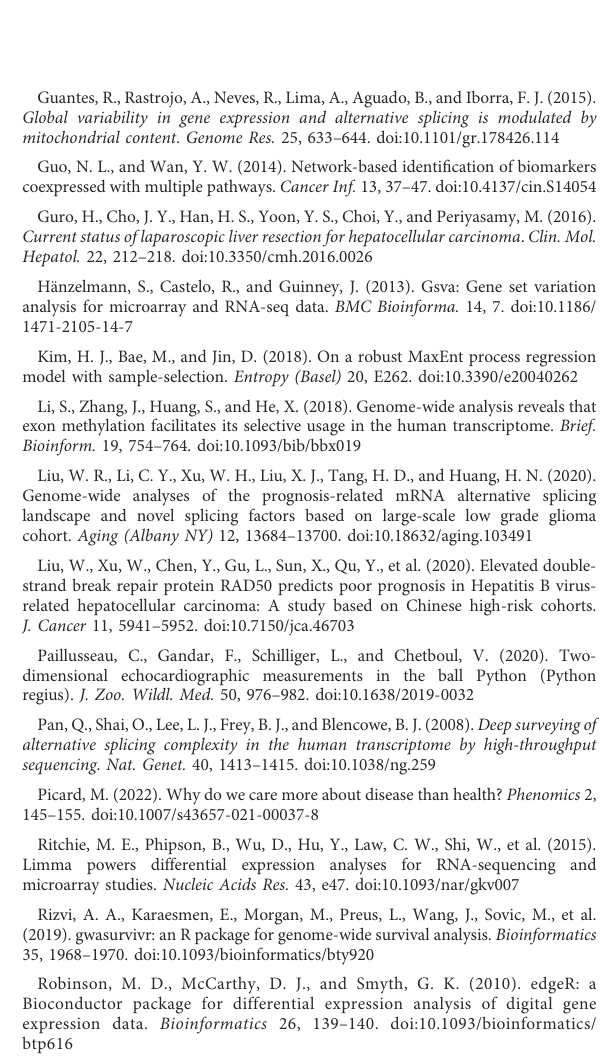
SUPPLEMENTARY FIGURE S1 Signi fi cant degree of similarity between alternative splicing subtypes and various responses. SUPPLEMENTARY FIGURE S2 Flowchart of this